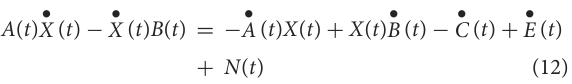
additive noise N(t) is presented as follows.